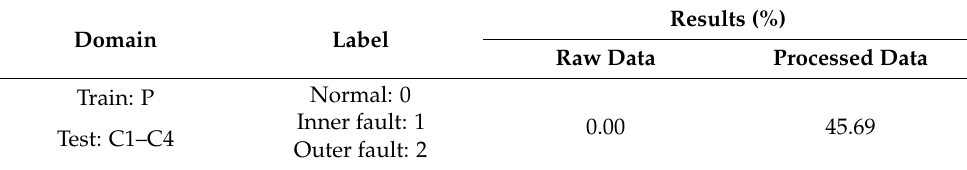
Table 4. Results of case 1.